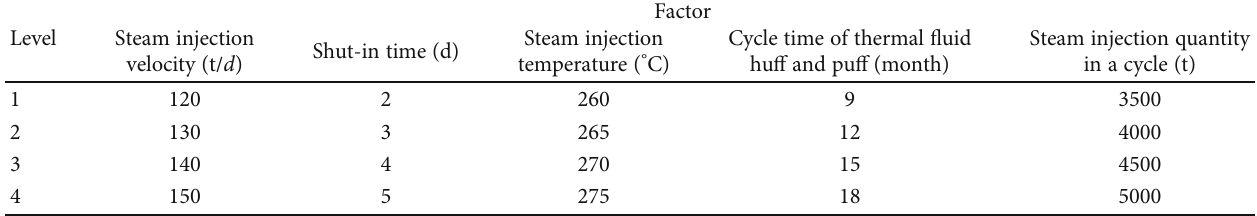
Table 5: Orthogonal design factors and level values in the thermal fl uid hu ff and pu ff .